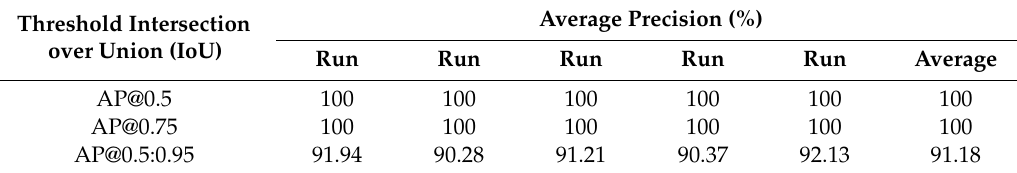
Table 3. Average precision (AP) of the final detection result (%).